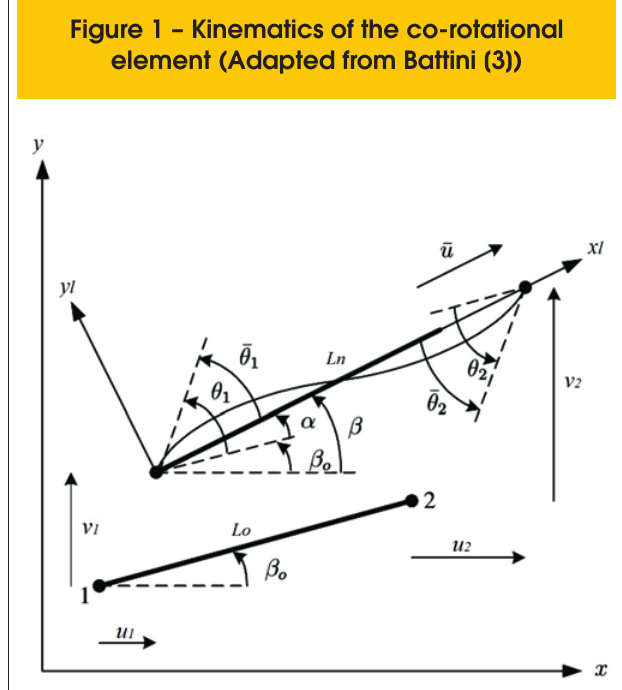
Figure 1 – Kinematics of the co-rotational element (Adapted from Battini